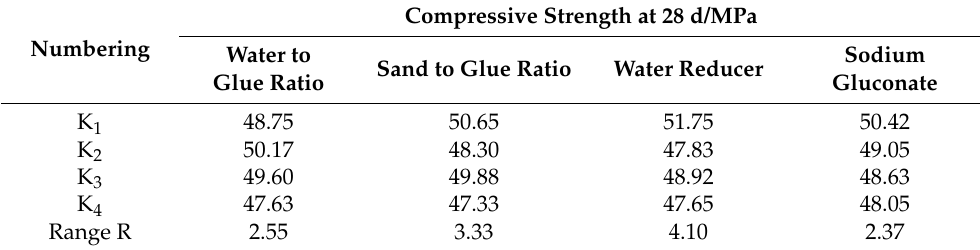
Table 11. Influence of various factors on the compressive strength at 28 d.